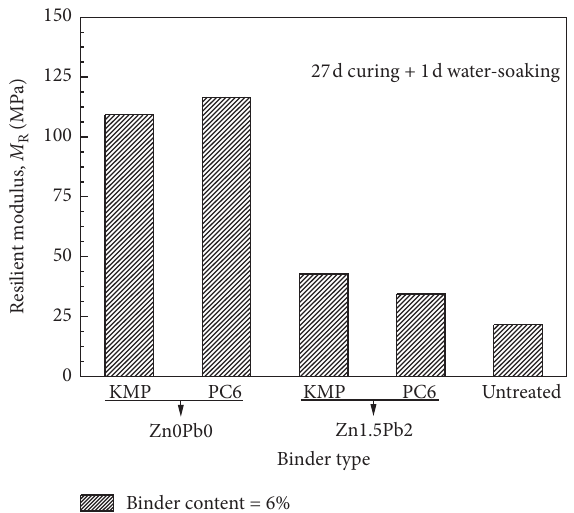
Figure 7: Measured resilient modulus for the stabilized and untreated